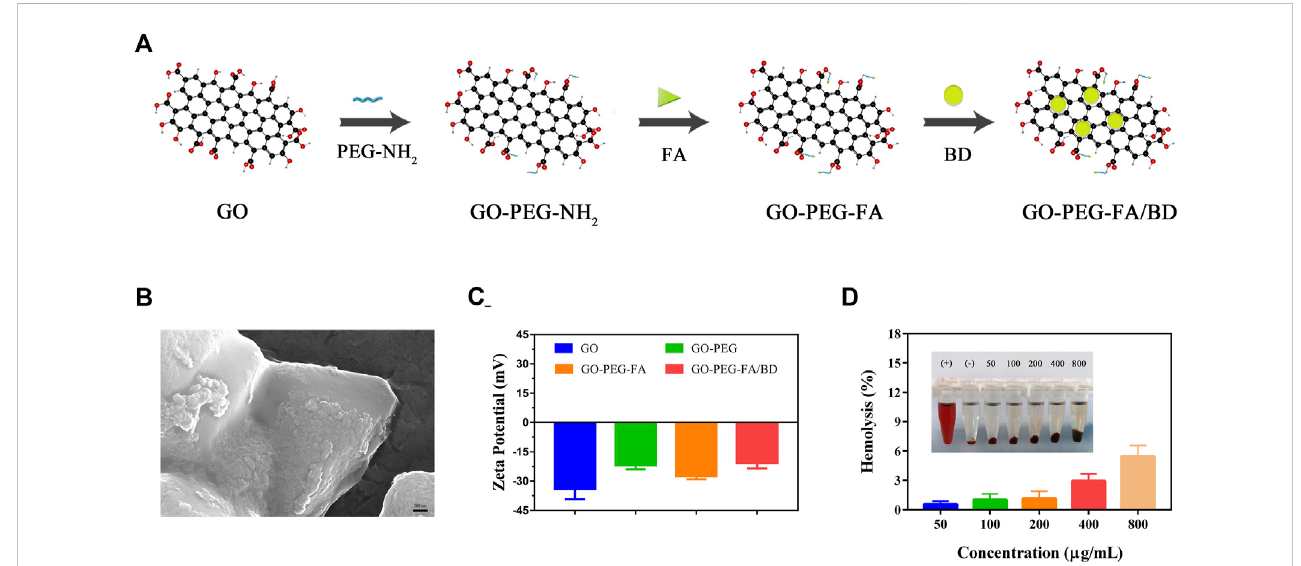
FIGURE 1 (A) Illustration of synthesis process of the nanoparticles. (B) SEM image of GO-PEG-FA/BD. (C) Zeta potential of GO, GO-PEG, GO-PEG-FA and GO- PEG-FA/BD. (D) Hemolysis analysis of the